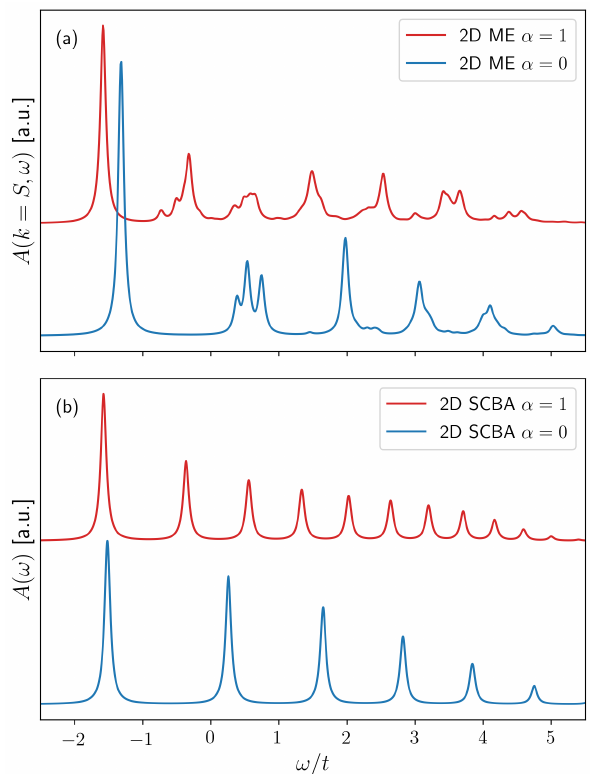
Figure 3: Spectral function A ( k , ω ) (13) of a single hole in the 2D t – J ( α = 1) and without ( α = 0) magnon-magnon interactions correctly included in the model calculated using: (a) the ME method, (b) the SCBA approach following Ref. [ 31 ] . All parameters as in Fig. 2 and k = S ≡ ( π/ 2, π/ 2 ) . Note that in the SCBA calculations for α = 0 ( α = 1) constraints C1 , C2 excluded (included),